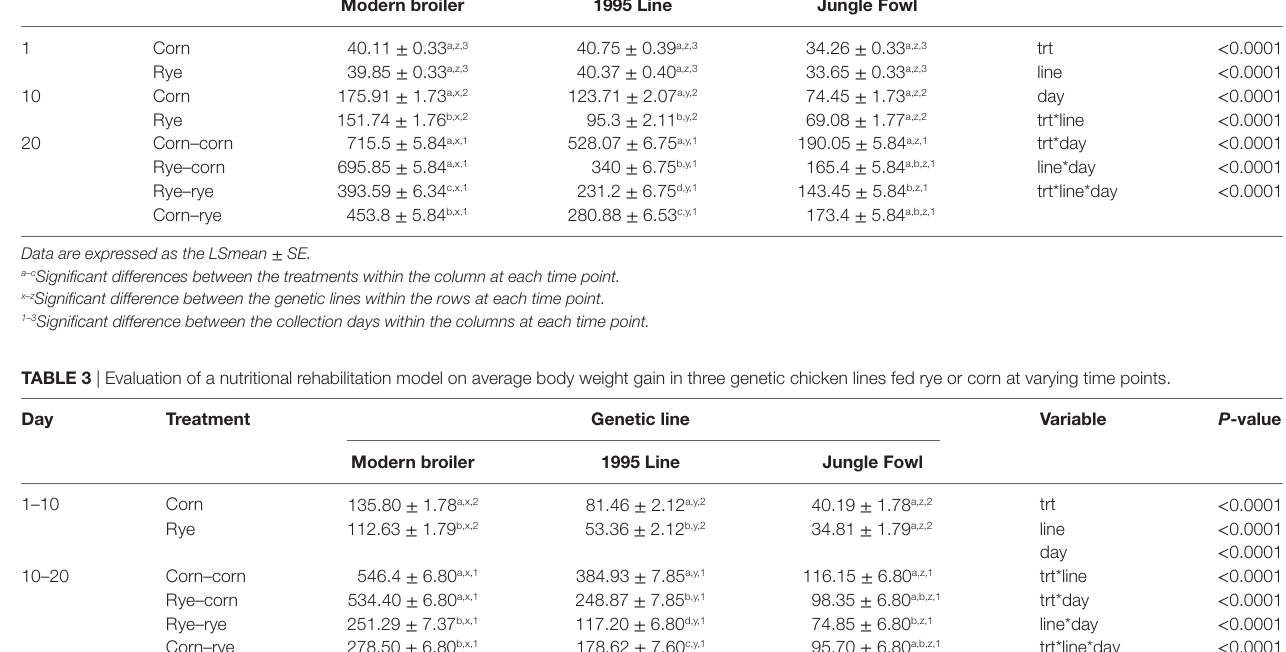
TaBle 2 | Evaluation of a nutritional rehabilitation model on body weight in three genetic chicken lines fed rye or corn at varying time points. Day Treatment